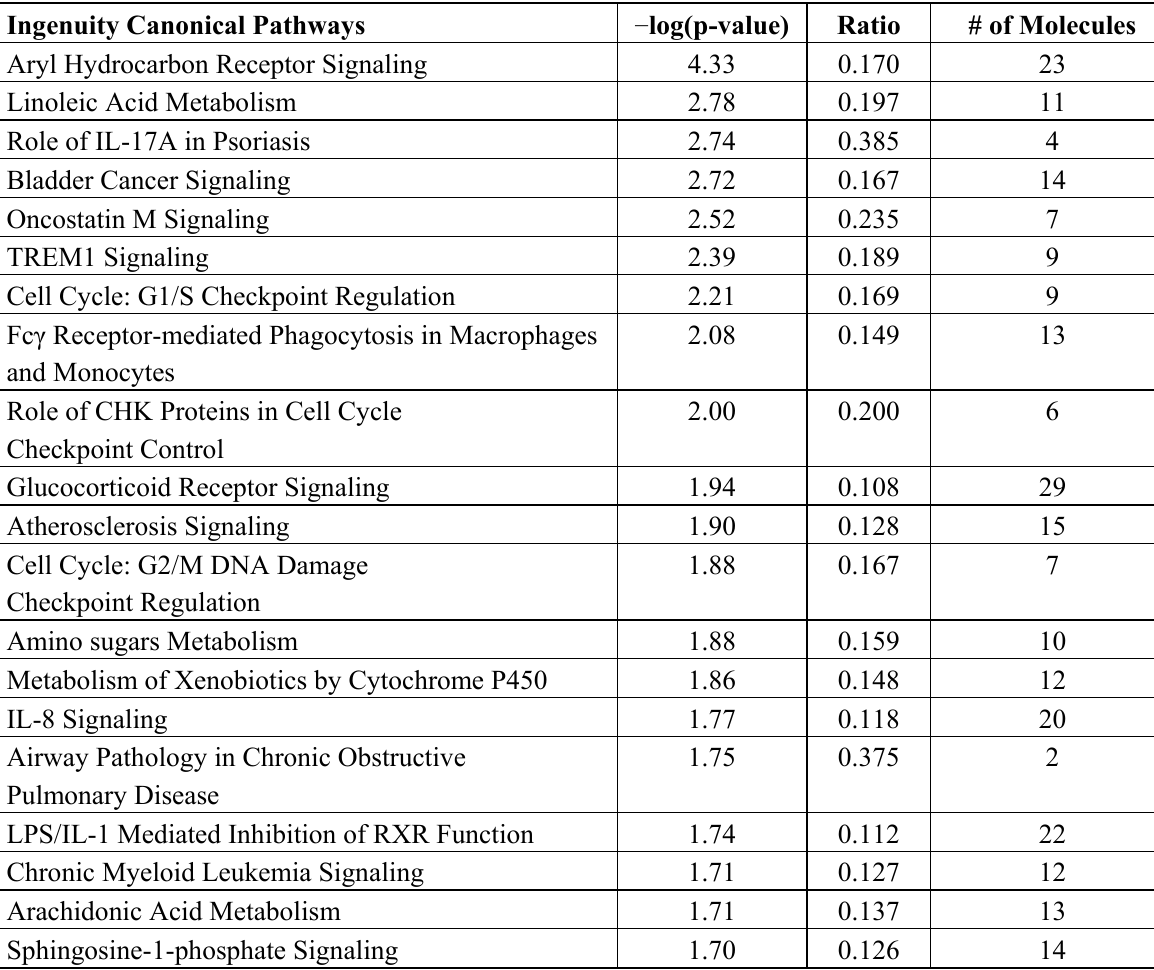
Table 3. Significant canonical pathways at 24 h post-heat exposure. 229 Ingenuity Canonical Pathways were scored at 24 h post-heat exposure; only the 36 listed pathways fit the cut-off of p -value ≤